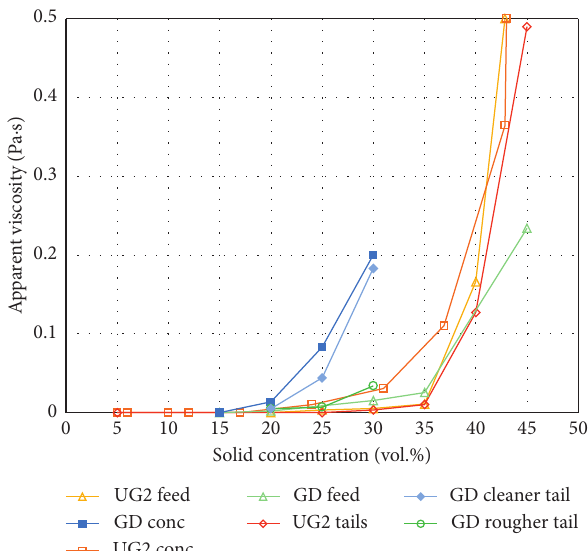
Figure 3: The comparison of the apparent viscosity (at 160s − 1 ) of the UG2 and Great Dyke flotation samples at different solid concentrations (after [19]).